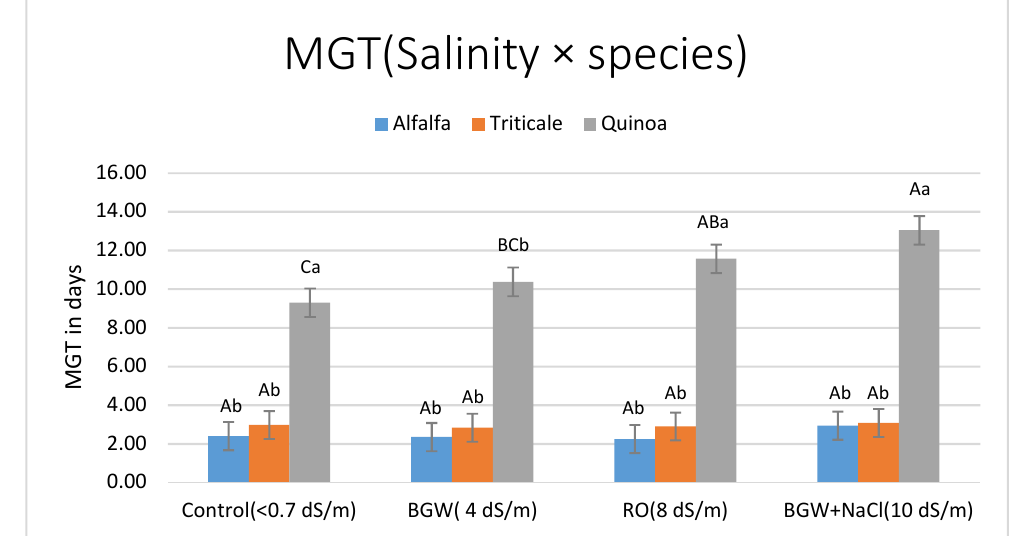
Figure 2. Mean germination time (MGT) (days) of alfalfa, triticale, and quinoa. MGT in days for alfalfa, triticale, and quinoa with salinity × species interaction at four di ff erent salinity levels. A, B, C letters correspond to significant di ff erences in the MGT within the species at di ff erent salinity levels and a, b letters correspond to statistically significant di ff erences in the MGT between the species at α ≤ 0.05. Standard errors for MGT of species x salinity are constant for alfalfa ( ± 0.73), triticale ( ± 0.72), and quinoa ( ± 0.73) respectively.